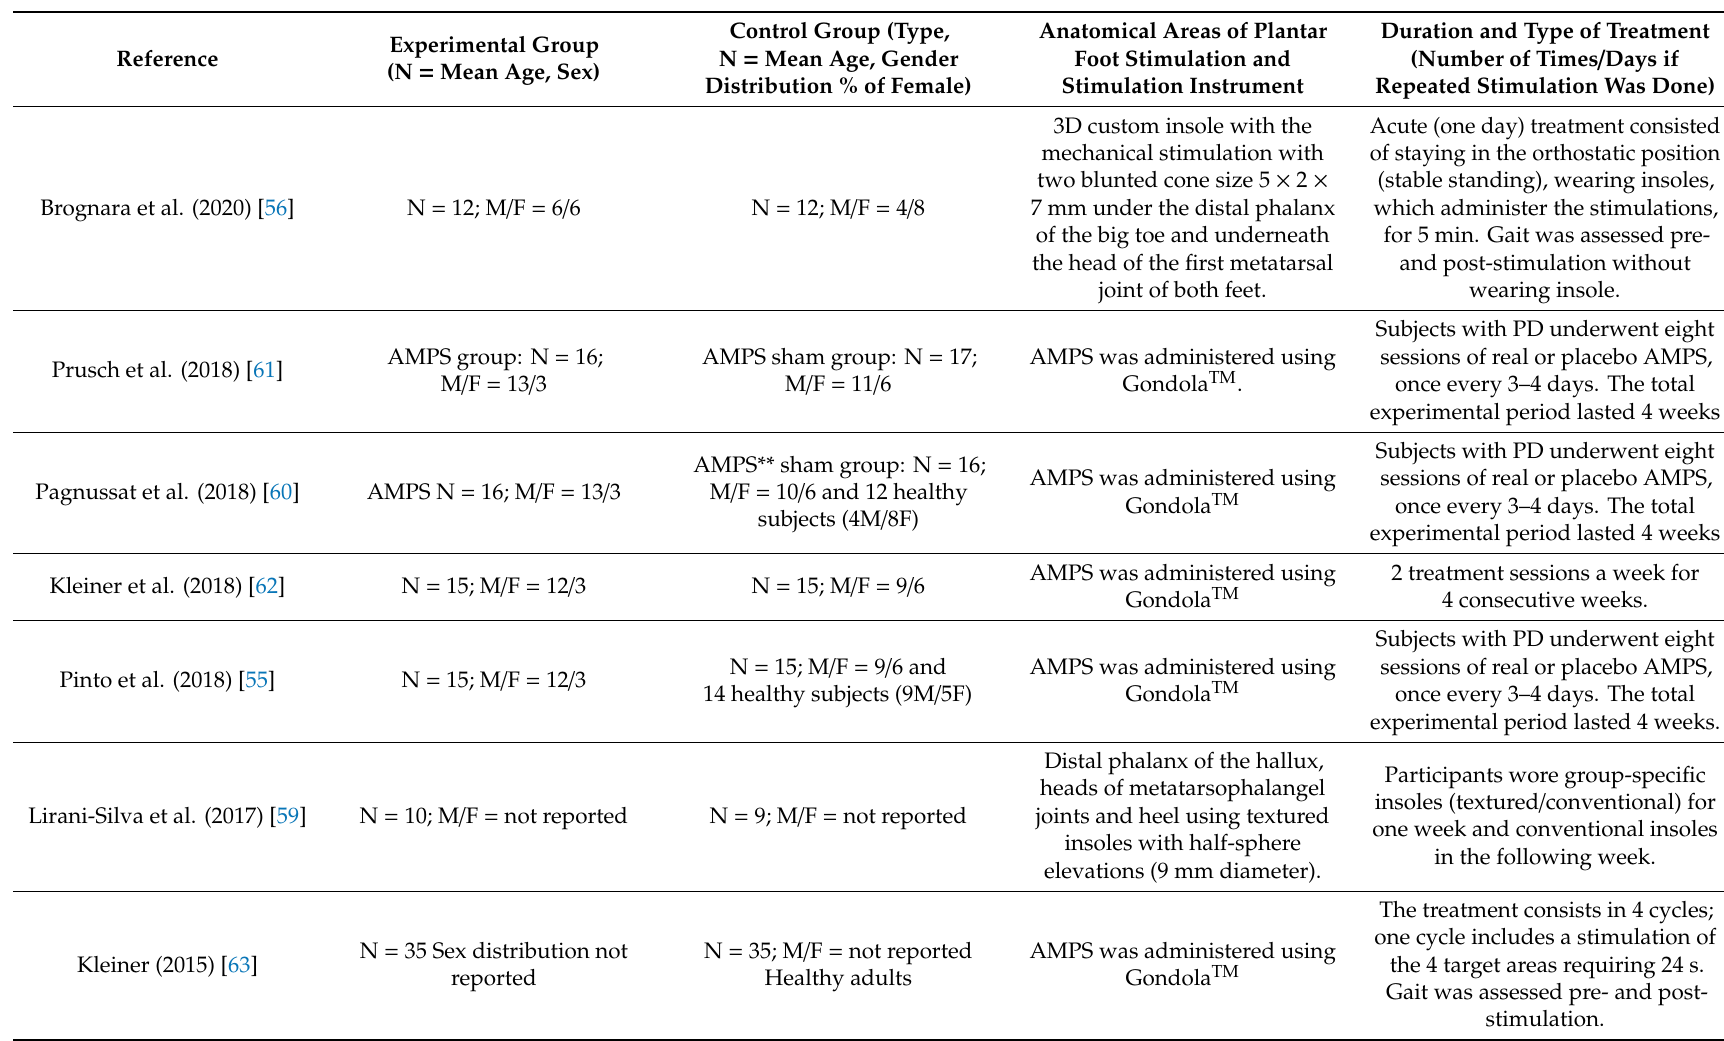
Table 2. Characteristics of protocol for mechanical plantar foot